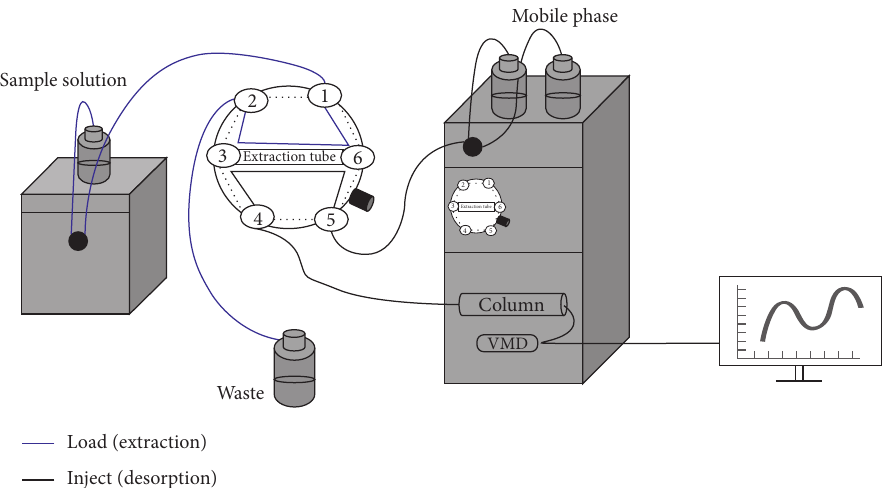
Figure 2: Construction of an online in-tube SPME-HPLC online